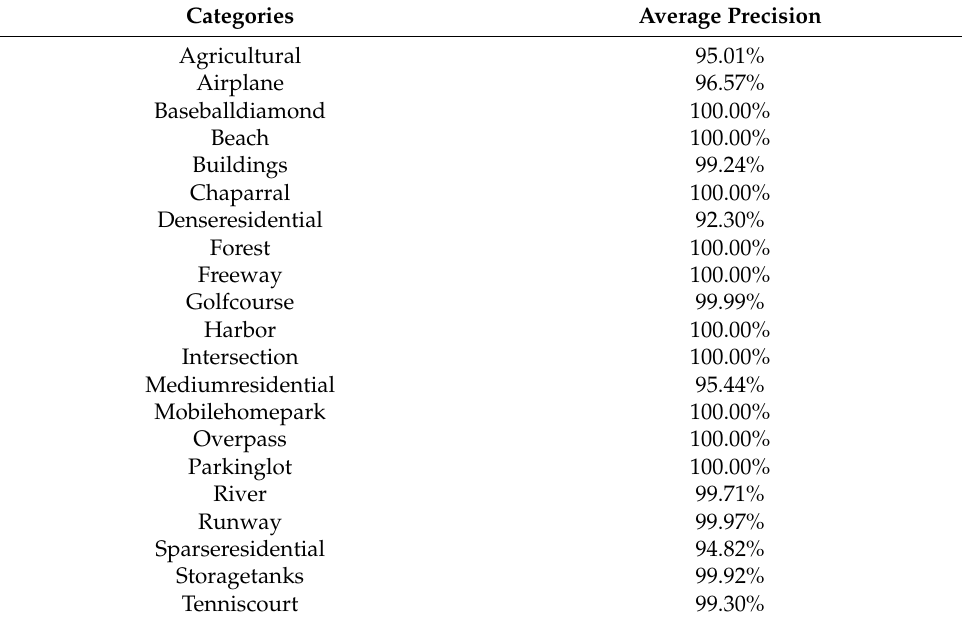
Table 5. Performance of each category of the UCM dataset.